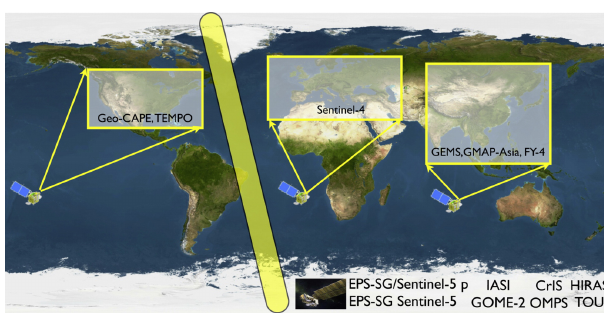
Figure 43. Constellation of geostationary and low-Earth orbiting satellites planned for the coming decade that will measure tro- pospheric ozone. Current instruments that measure tropospheric ozone, e.g. TES or OMI, but will not be continued in the future are not listed (from Bowman,